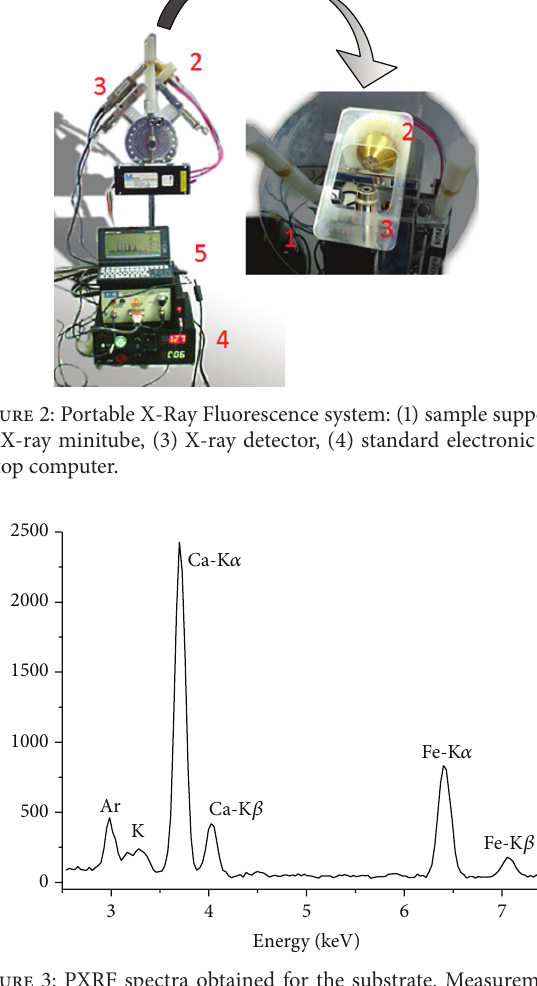
Figure 3: PXRF spectra obtained for the substrate. Measurement time 300 s.